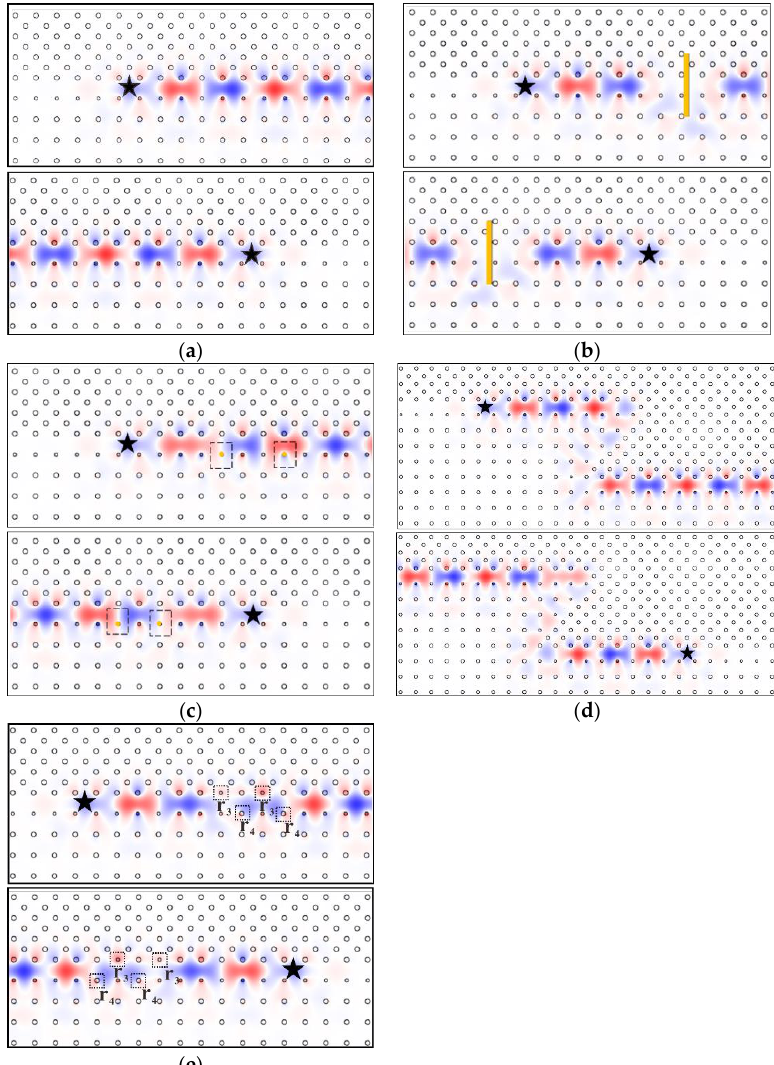
Figure 7. The electric field distributions for E z at 4.2926 GHz in the unidirectional slow light PCW for parameters r 1 = 0.078 a , r 2 = 0.115 a ( a ) in the absence of the obstacles; ( b ) with an inserted metal reflector (indicated by the yellow rectangle); ( c ) with two YIG rods replaced by Copper rods (circled in the black rectangles) of the same size; ( d ) with a Z-shaped interface; ( e ) with rod defects (circled in the black rectangles and the corresponding rod radii are r 3 = 0.08 a and r 4 = 0.11 a respectively). The top and the bottom plots in ( a – e ) correspond to the results of the externally applied magnetic field along + z and − z direction, respectively. The point source is indicated by the black star. Blue and red colors represent negative and positive field strength